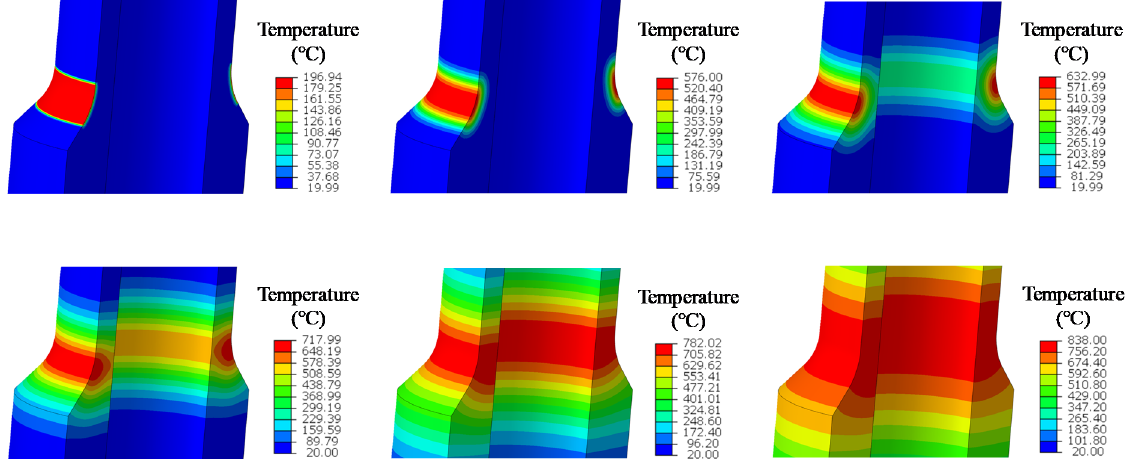
Figure 11. Distribution contour of temperature in the direction of drill pipe wall thickness at differ- ent times.